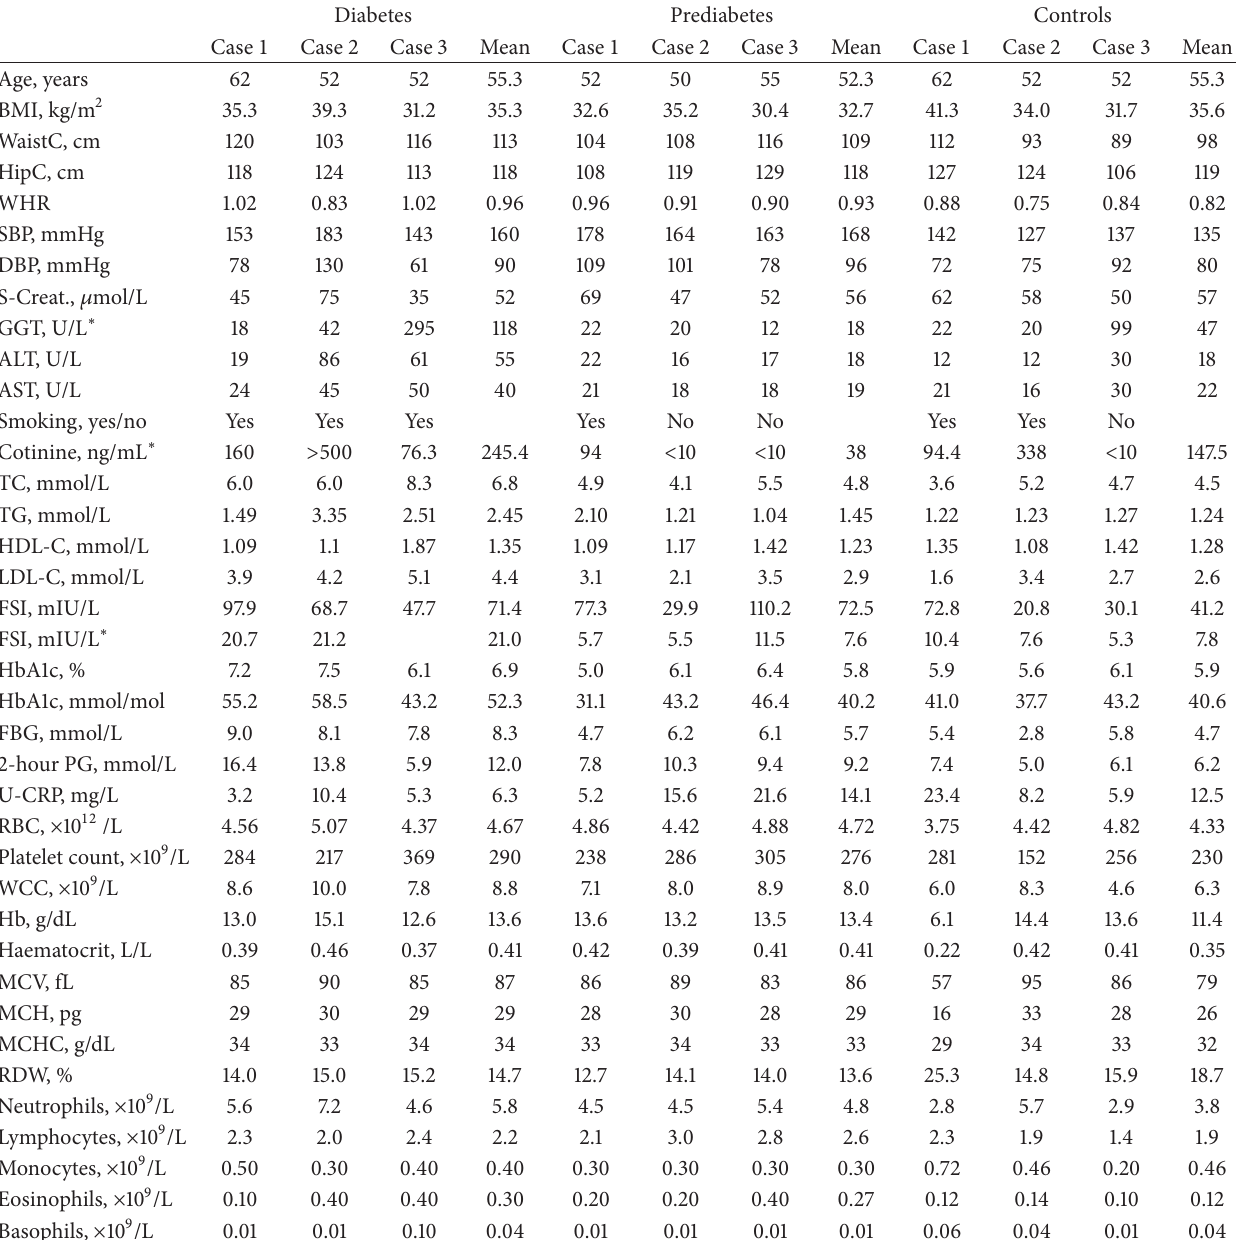
Table 1: Characteristics of all